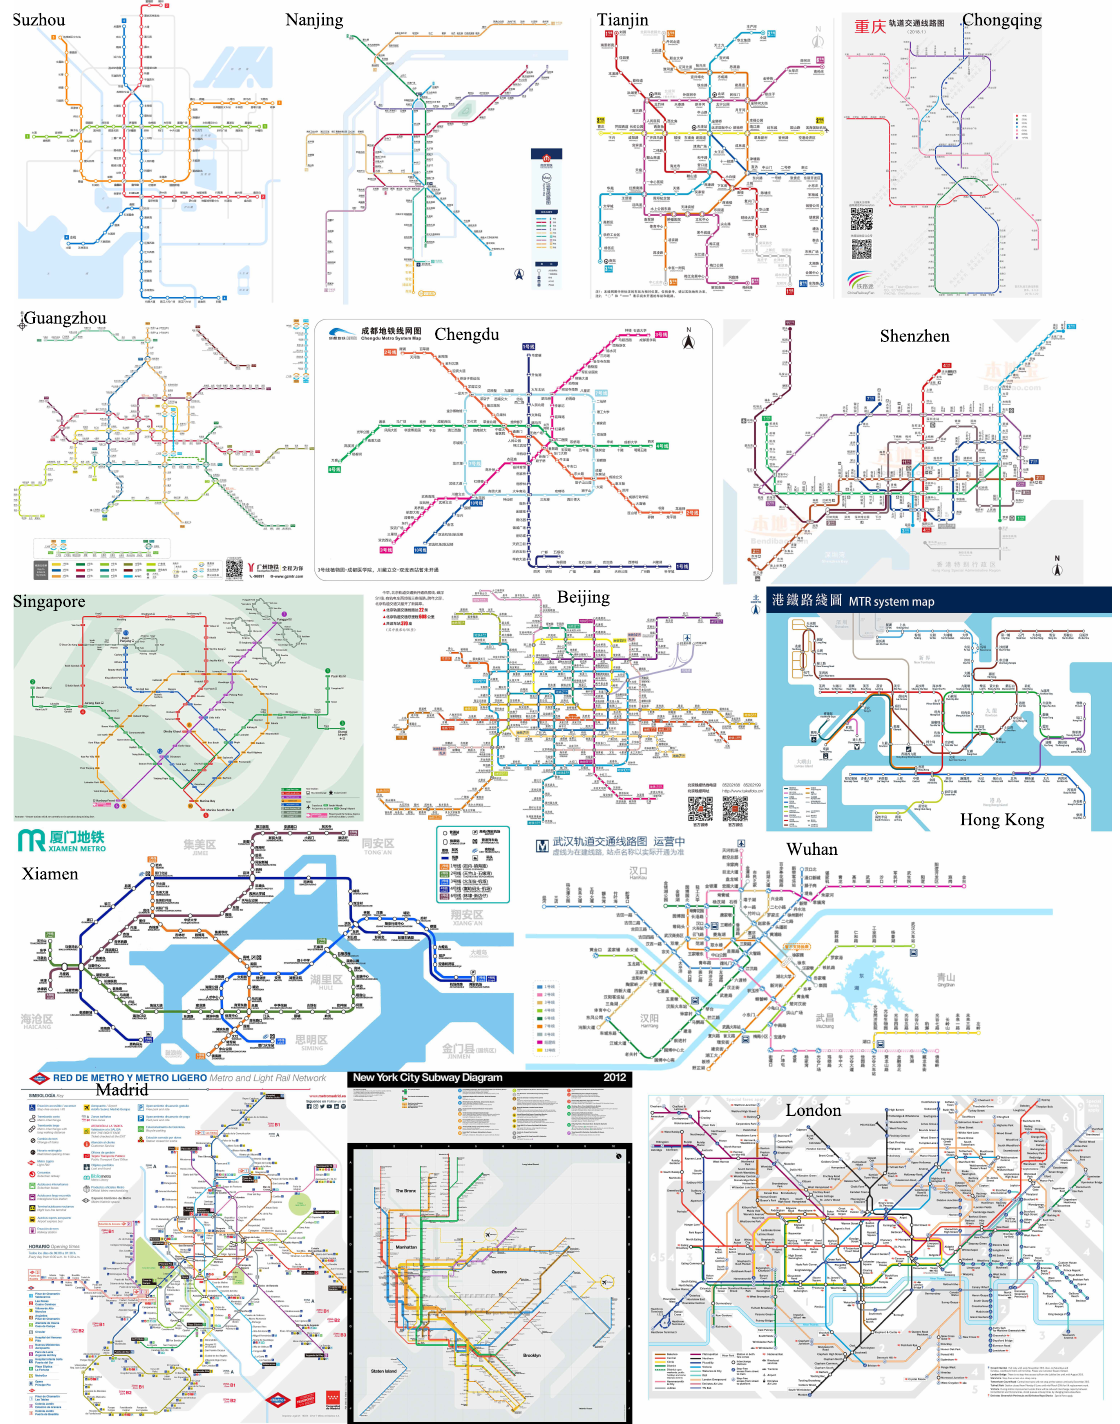
Figure 9. The employed schematic metro maps for the preparation of